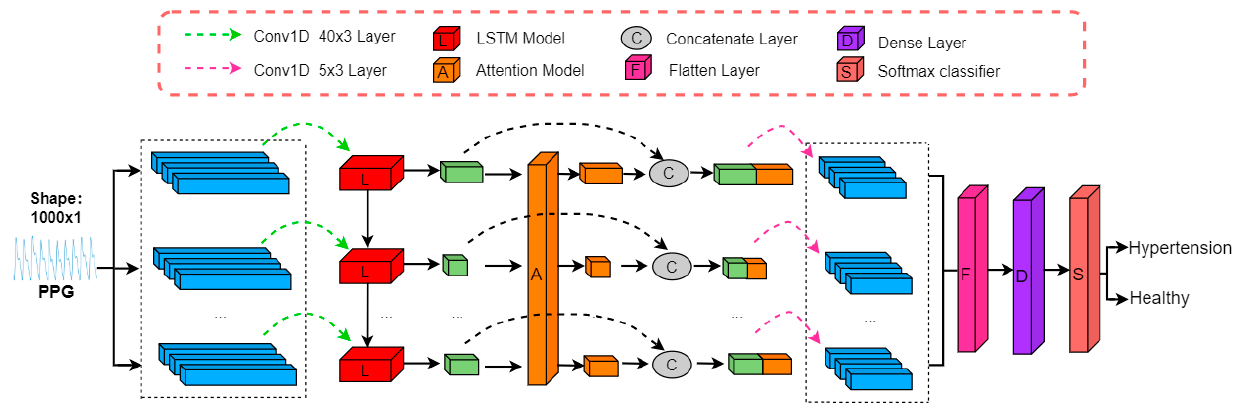
Figure 7. Structure diagram of LSTM-Attention. LSTM Block